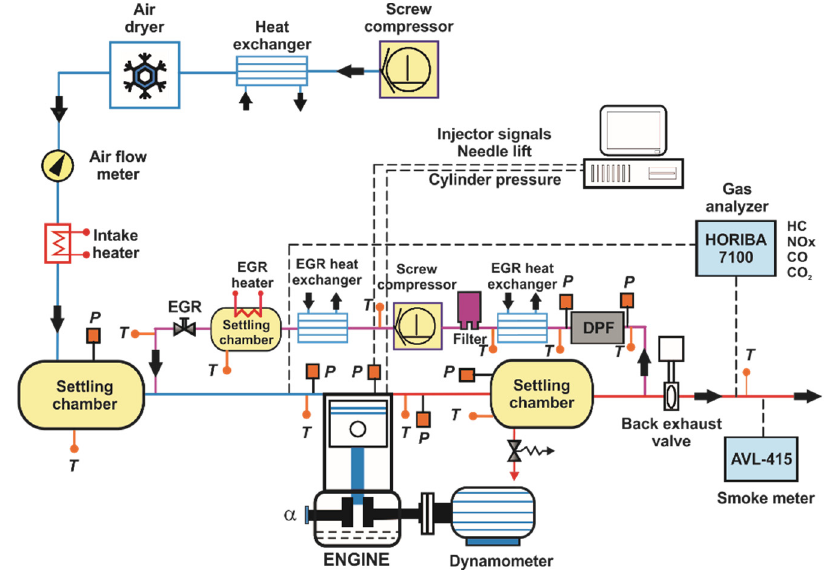
Figure 1. Test cell setup.